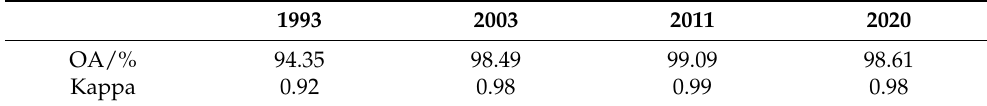
Table 3. The classification accuracy in the different years.